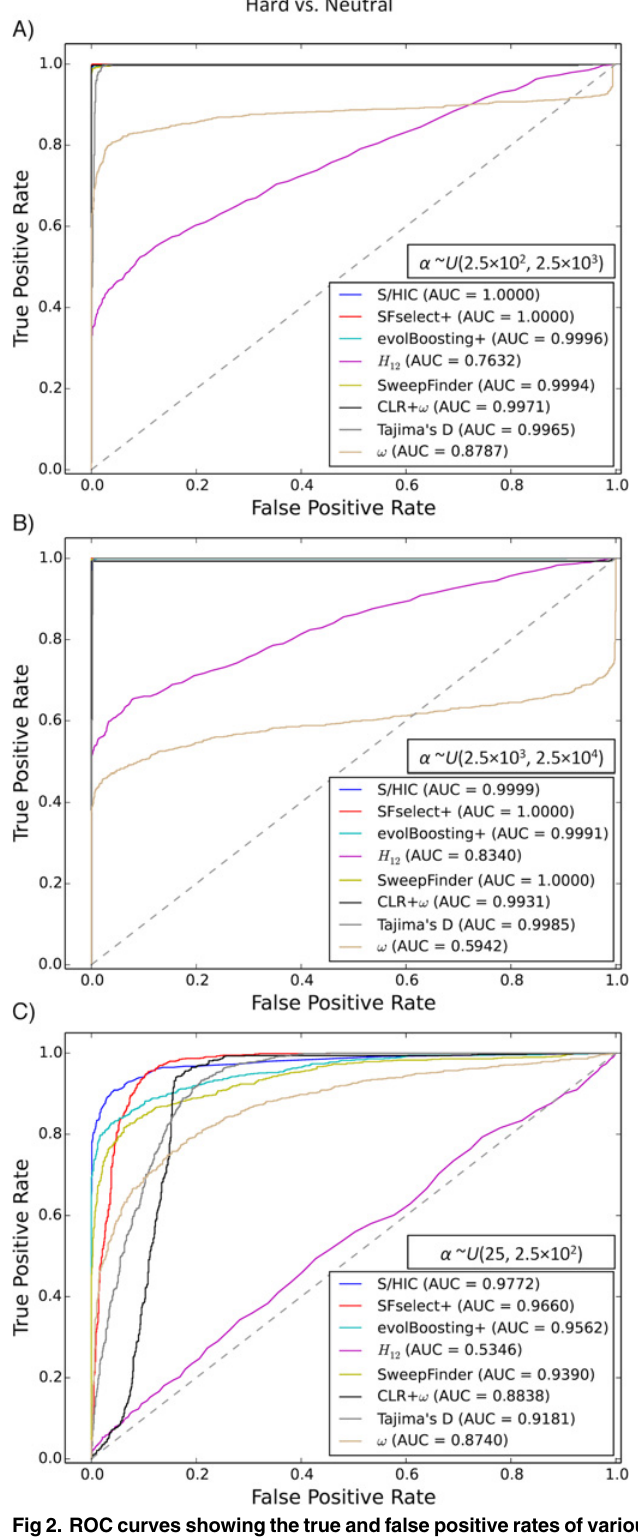
Fig 2. ROC curves showing the true and false positive rates of various methods/statistics when tasked with discriminating between regions containing a hard sweep and neutrally evolving